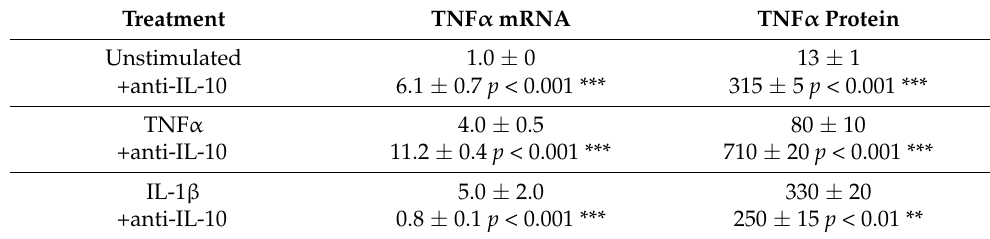
Table 3. Intestinal epithelial cells express an endogenous IL-10 activity dependent on stimulus.